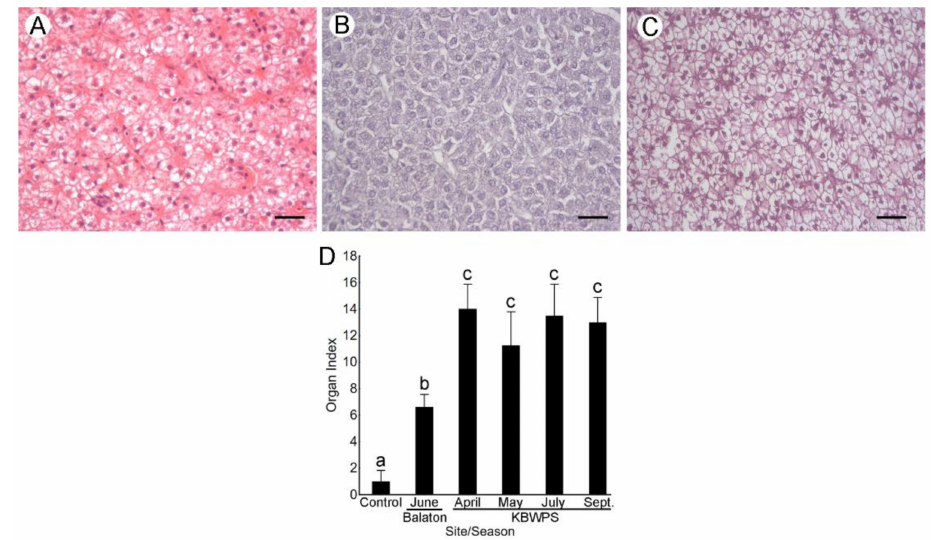
Figure 3. Histopathological alterations of the hepatic tissue of fish caught from Lake Balaton and Kis-Balaton Water Protection System (KBWPS). ( A ) Control individuals demonstrating normal hepatic histology. ( B ) Individuals caught from Lake Balaton displaying severe basophilia and rounding of cells. ( C ) Individuals caught from KBWPS showing pronounced vacuolization, loss of glycogen as well as pyknosis. H&E staining. Scale bars: A and B: 25 µ m, C: 50 µ m. ( D ) Hepatopancreas indices obtained after the semi-quantitative analysis of the histopathological alterations. Different letters above the SD bars indicate statistical significance (Tukey’s HSD, p <